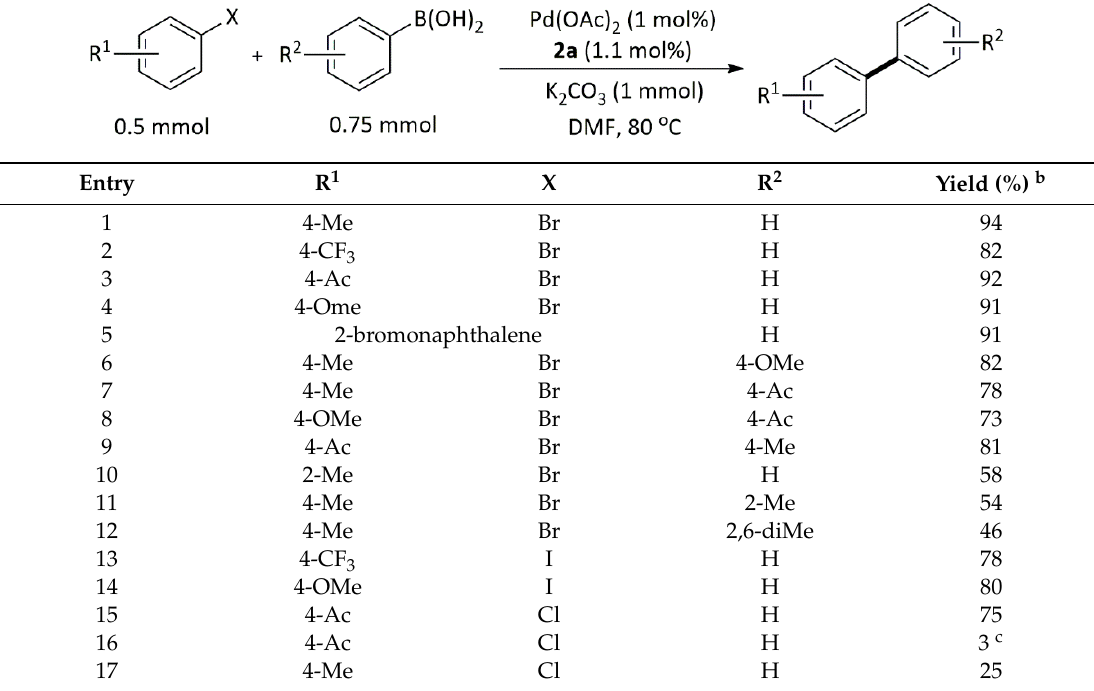
Table 4. Substrate scope for the SM reaction using ligand 2a under optimised reaction conditions. a